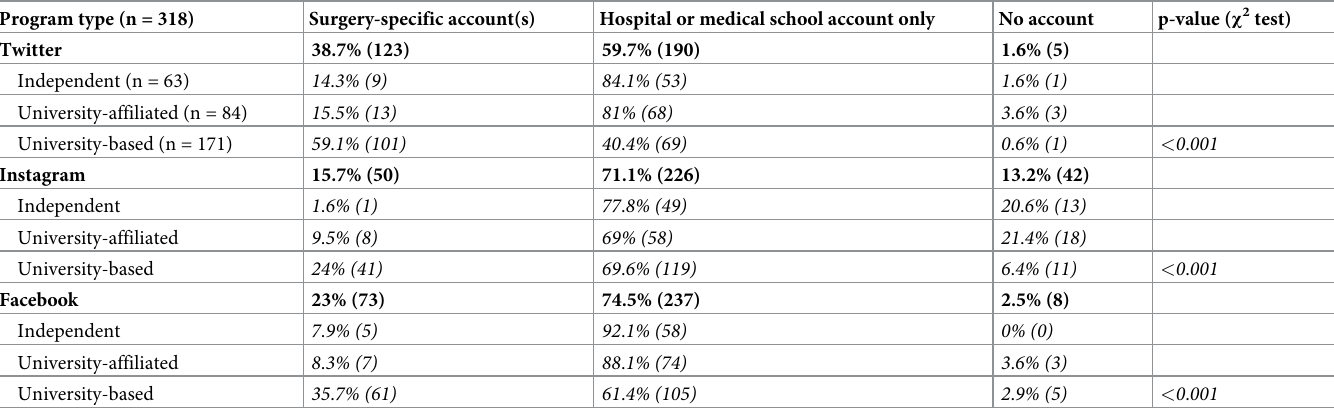
Table 1. Distribution of social media account types by residency program